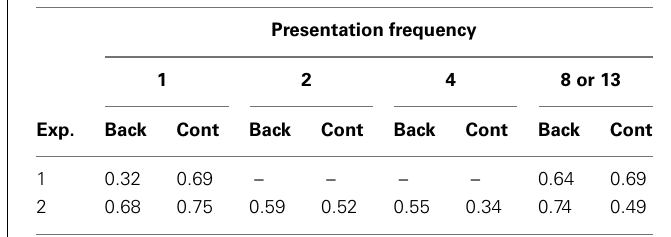
Table 2 | Correlations between liking and emotion-intensity ratings in Experiments 1 and 2 (all p s < 0.05).